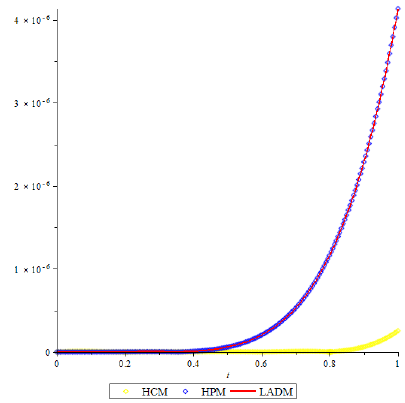
Figure 3. Comparison of the error function E 3,5 ( t ) for R ( t ).